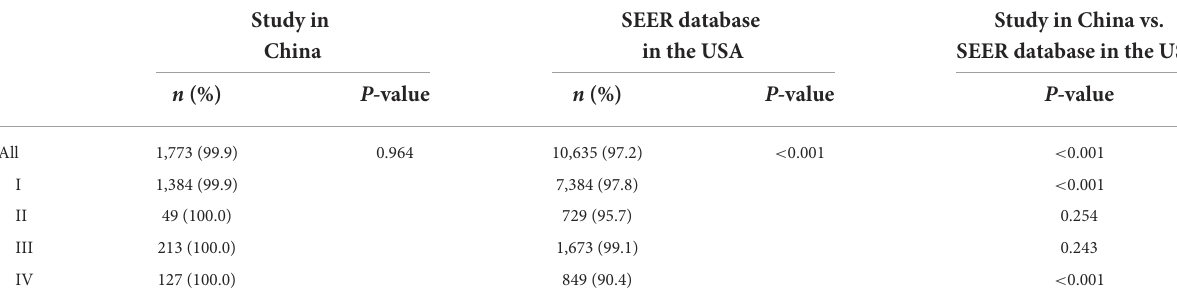
TABLE 5 Comparisons on surgery of DTC patients between the study in China and SEER database in the USA. Study in SEER database Study in China vs. China in the USA SEER database in the USA